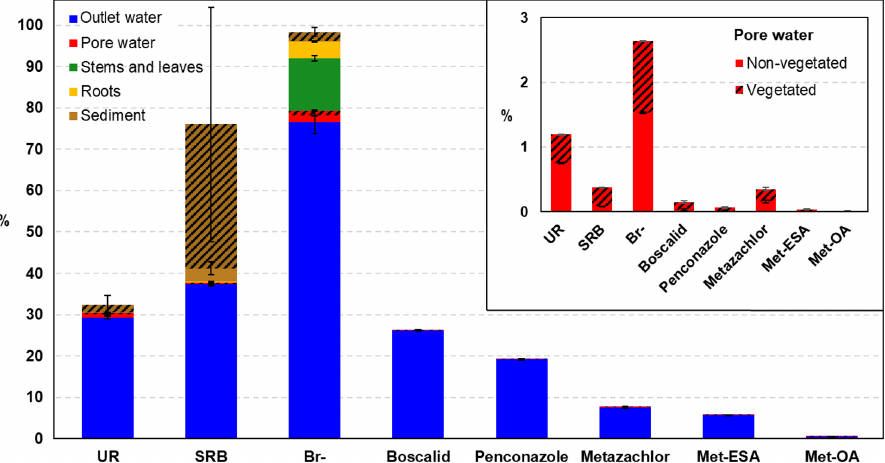
Figure 9. Final mass balance conducted at the end of the experiment in the different compartments. Note that the pesticides and their TPs could only be measured in the outlet and pore water compartments. The mass balance for the TPs was calculated according to the total amount of parent compound injected. The shaded area represents the percentage measured in the vegetated zone. The mass balance for the pore water compartment is detailed in the inset